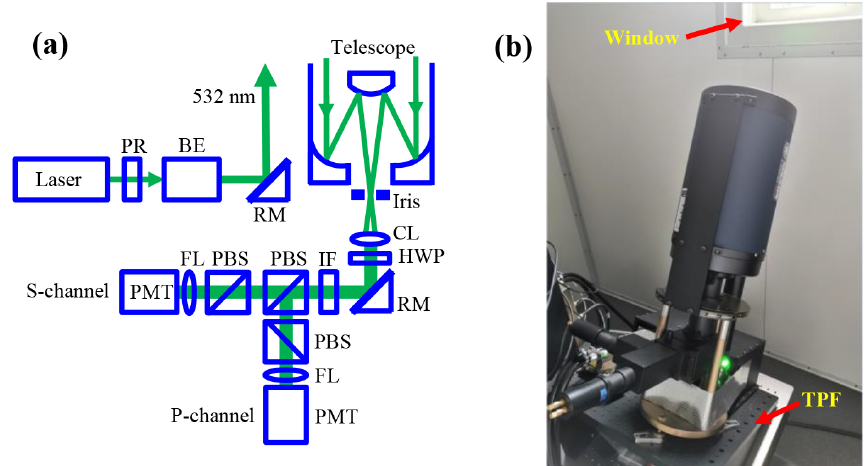
Figure 1. (a) Schematic optical layout of the TPL. PR, polarizer, beam expander (BE), reflecting mirror (RM), collimating lens (CL), half-wavelength plate (HWP), interference filter (IF), polarization beam splitter (PBS), focusing lens (FL) and photomultiplier tube (PMT). (b) A picture of the lidar optics. The whole optics is placed on a tilted platform (TPF). A window permits the propagating laser beam and atmospheric backscatter to pass through without being